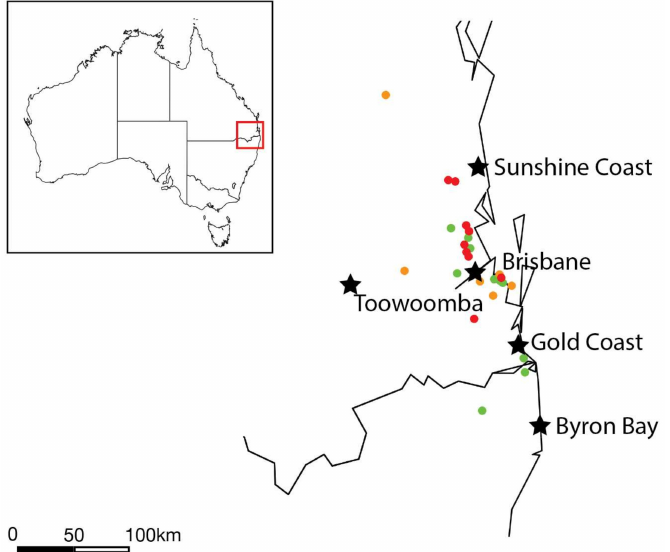
Figure 3. Map showing the koala collection area spanning from north of the Sunshine Coast, Australia, across the New South Wales and Queensland boarder to Byron Bay in the south. Key urban areas are indicated by black stars, while the koala collection locations are colour coded by virus abundance with green points indicating no virus with the sample, yellow indicating low levels of virus (below 0.01% of total reads) and red indicating high abundance of virus (>0.01% of total